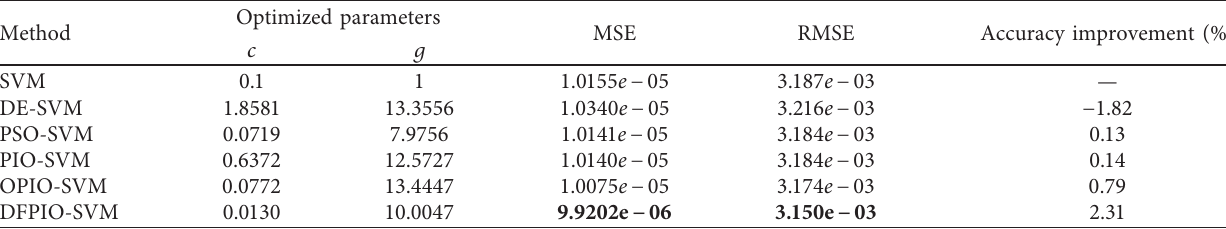
Figure 9: Iterative curves of three optimization Table 2: Comparison of prediction accuracy for NARMA.